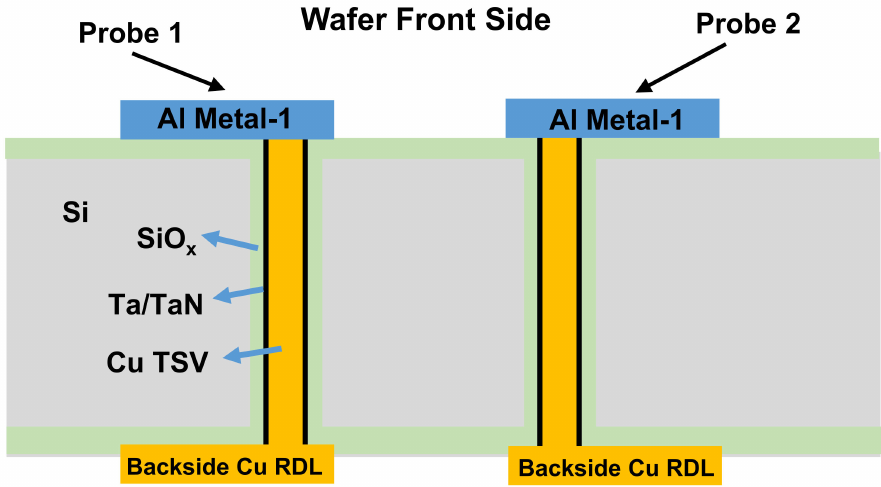
Figure 2. Schematic of the TSV structure and electrical setup for measuring TSV